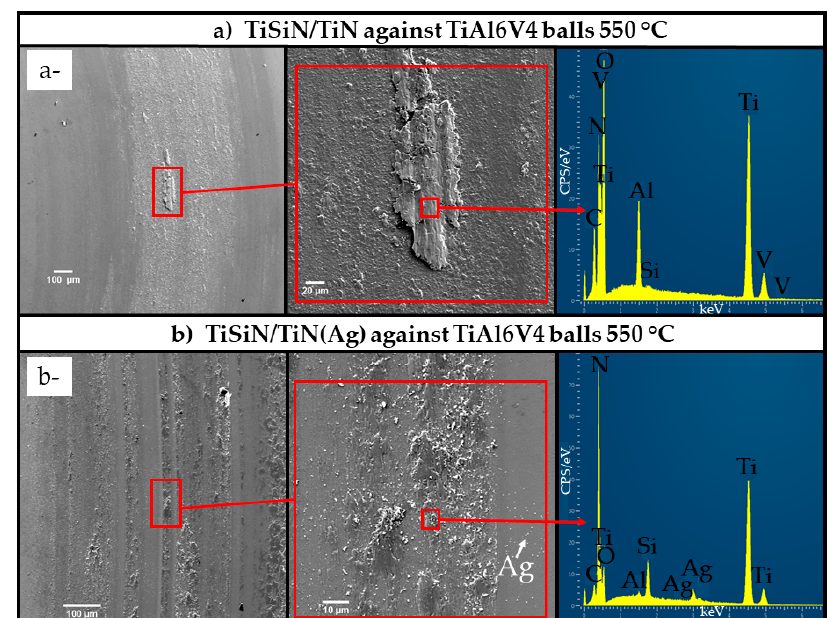
Figure 7. SEM micrographs of the wear tracks and wear debris, and the corresponding EDS analysis for the ( a ) reference and ( b ) Ag-doped coatings tested at 550 °C against Tial6V4 balls.